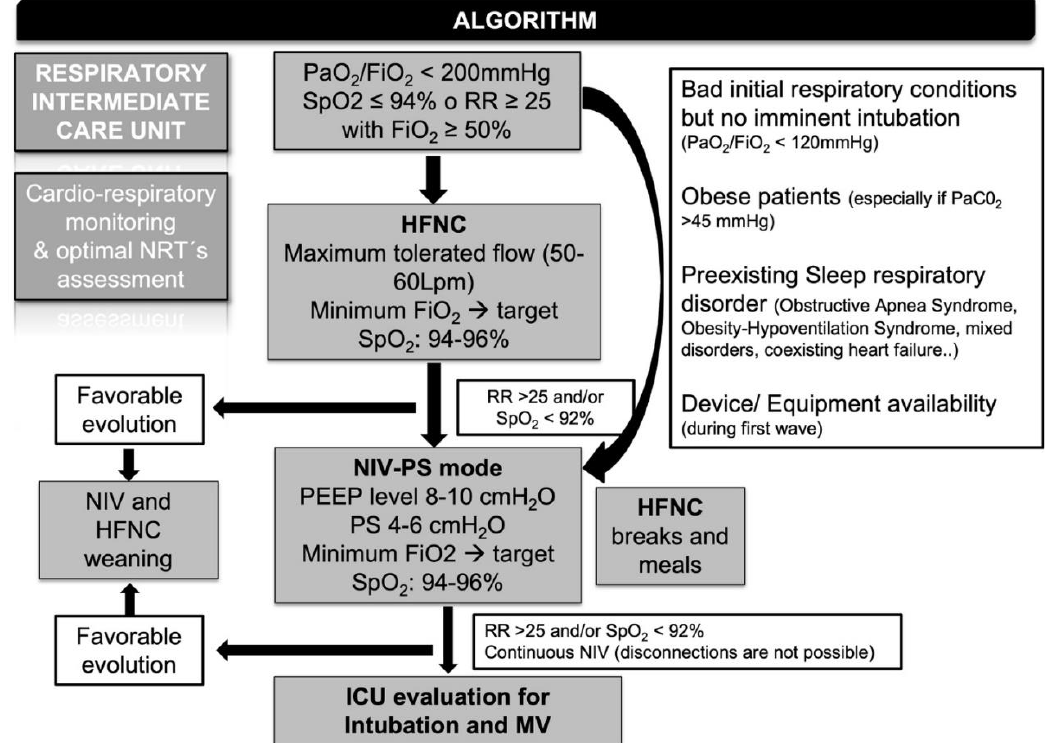
Figure 1. Algorithm at IRCU: Sequential non-invasive respiratory support; sequential non-invasive respiratory support. NRT, non-invasive respiratory therapy; IRCU, intermediate respiratory care unit; PaFiO 2 , partial arterial pressure of oxygen divided by inspired oxygen fraction; SpO 2 , oxygen saturation by pulse oximetry; RR, respiratory rate; FiO 2 , inspired oxygen fraction; HFNC, high flow nasal cannula; NIV, non-invasive ventilation. PEEP; positive end-expiratory pressure; PS, pressure support; PaCO 2 : partial arterial pressure of carbon dioxide; MV, mechanical